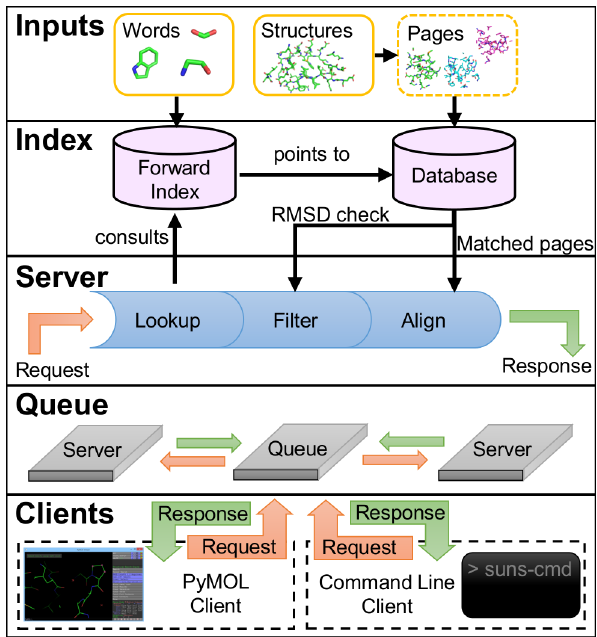
Figure 1. Overview of Suns algorithm and architecture. (Inputs) The search index is built from two inputs: a set of words to recognize and a set of protein structures to search subdivided into pages. (Index) The two underlying data structures are a forward index that translates words to matching pages and a database of every page which translates matched words to atoms within each page. (Server) Each request to the server is broken into three steps: consult the forward index to find potentially matching pages, filter matching pages by RMSD to the query, and aligning successful matches to the query. (Queue) A message queue forwards requests from clients to servers, and forwards responses from servers to clients. (Clients) Suns provides two client interfaces: a PyMOL search plugin and the suns-cmd command line interface.